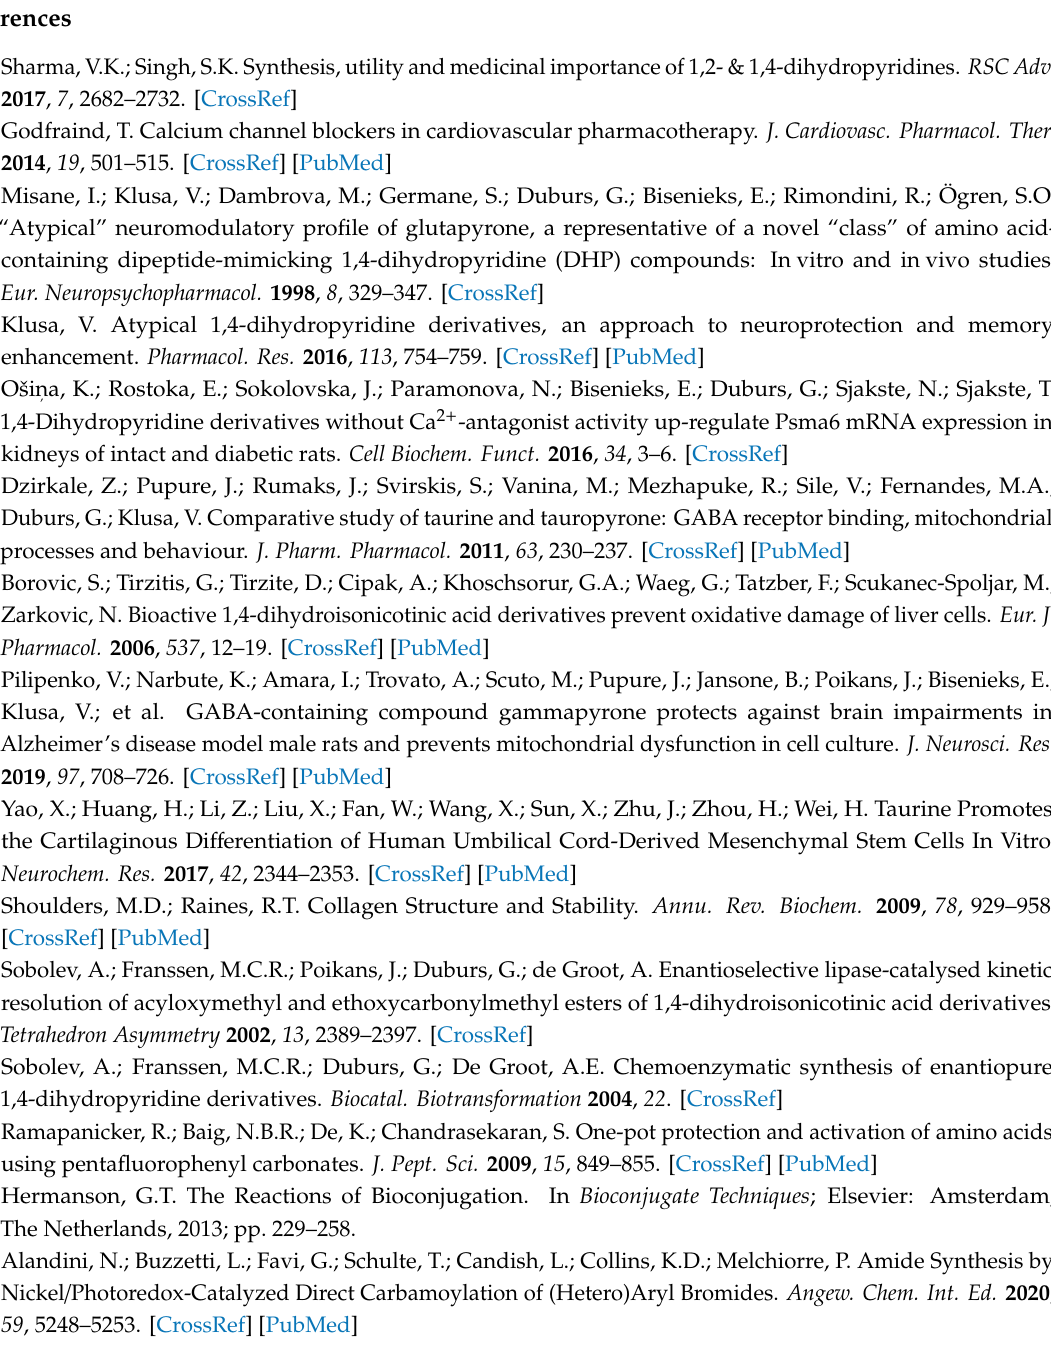
Supplementary Materials: 1 H NMR: 13 C NMR, IR, and LC-MS spectra of compounds 3 and 4 are available